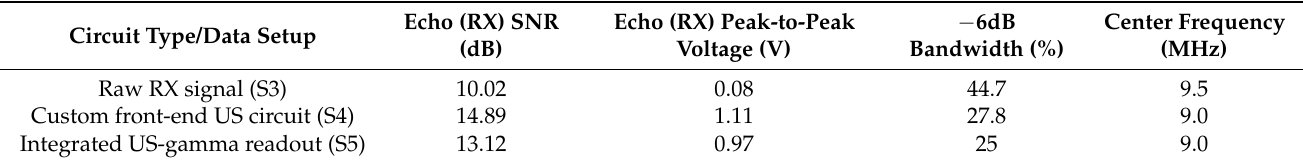
Table 2. Summarized performance parameters of the US probe via the acquisition of data with various front-end circuits. SNR: signal-to-noise